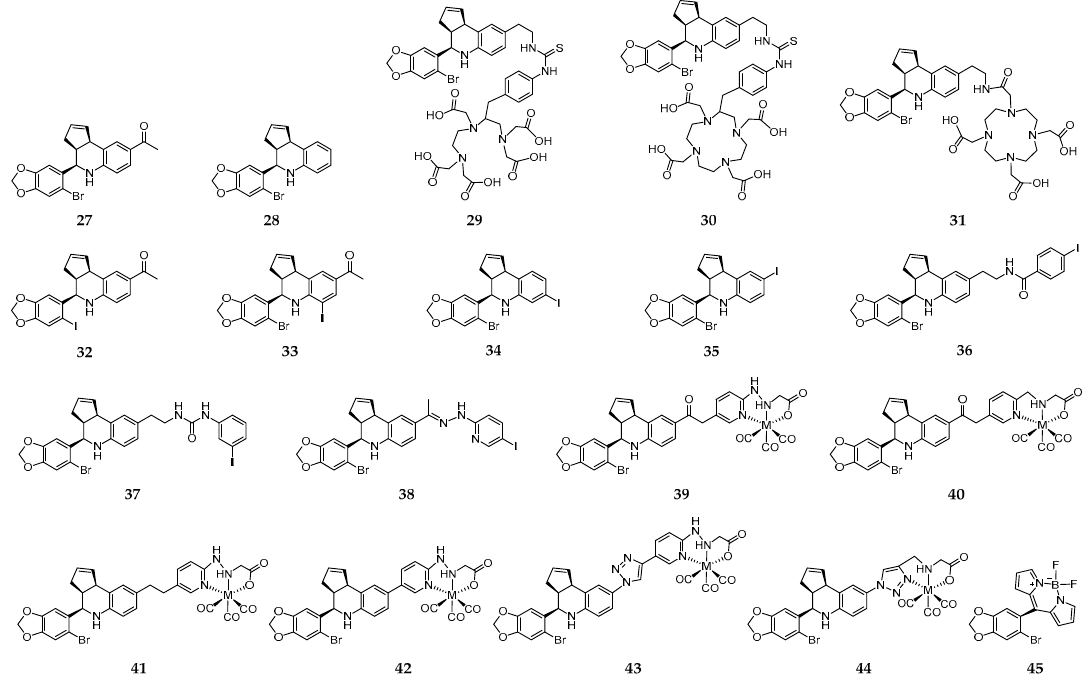
Figure 5. GPER-targeting molecules containing a tetrahydro-3 H -cyclopenta[c]quinoline core and a Bodipy-derived fluorescent probe. M = Re, 99m Tc.